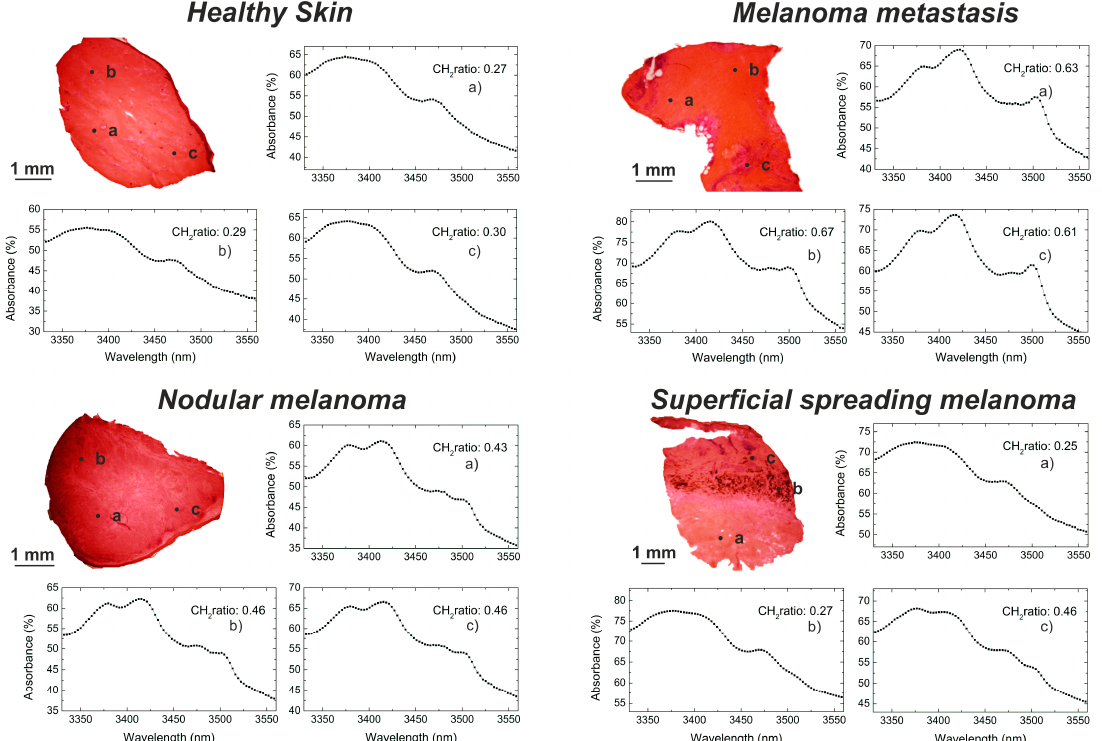
Figure 3. H&E stained pictures of healthy skin tissue, nodular malignant melanoma, superficial spreading malignant melanoma and melanoma metastasis investigated by the IR sensor. Infrared spectral information and CH 2 stretch ratio values have been obtained from three different biopsy spots. The plotted infrared spectra originate from a sample area of ~0.5 mm in diameter. Spectral shapes of healthy and cancerous tissue exhibit significant differences. The CH 2 stretch ratio values of malignant melanomas and melanoma metastasis are increased compared to the healthy tissue of reference.